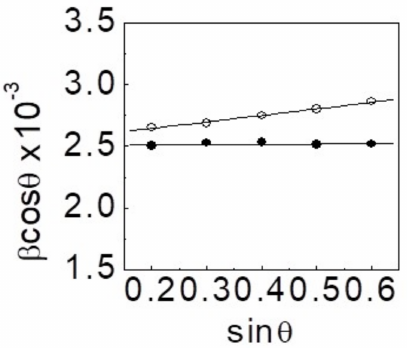
Figure 3. The plots of β cos θ versus sin θ for semi-wet ( ) and dry route ( ◦ ) derived PBZ50 powder obtained after crushing the